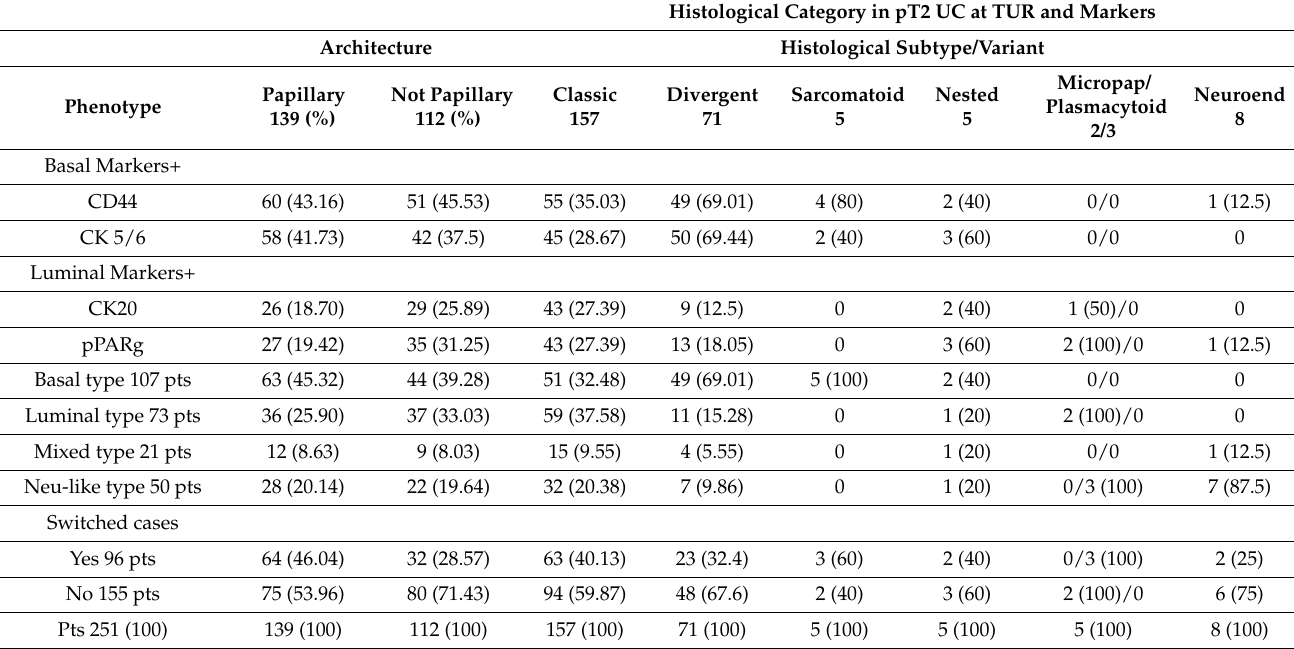
In contrast with the classic UC group, where all the phenotypical category results are equally distributed, tumors with divergent differentiation are mostly in the basal group (49/71, 69.01%), as well as for all sarcomatoid tumors (five cases). Nested UC (five pts) is